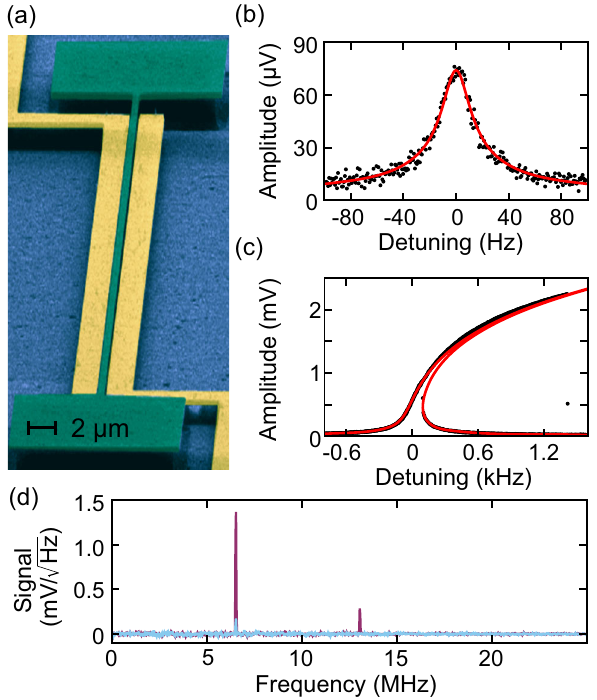
FIG. 1. Nanomechanical string resonator in the single-mode regime. (a) Scanning electron micrograph of the doubly clamped silicon nitride string resonator (green) and two control electrodes (yellow). (b) Linear response for a drive power of − 56 dBm along with a Lorentzian fit (solid red line). A constant noise background has been subtracted from the data ( 1 . 5 × 10 − 6 V). (c) Amplitude of forced vibrations for a moderately strong drive power of − 24 dBm as a function of drive frequency along with a fit (solid red line, see Appendix B). (d) Vibration spectra for a resonant drive applied at the OOP mode in the linear regime ( − 46 dBm, light blue), and for a stronger drive (5 dBm, purple) that exhibits an overtone at twice the drive frequency. Even under strong driving, no other modes are excited. A noise background has been subtracted from the